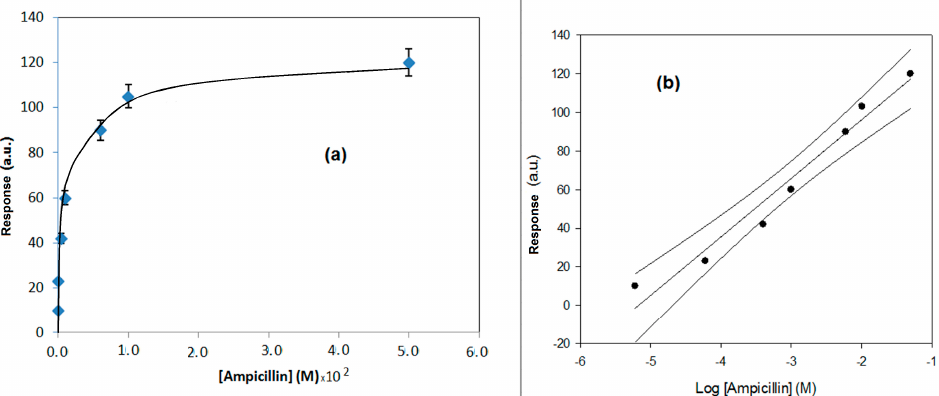
Figure 6. ( a ) Behavior of the response of the direct method based on flow SPR vs. concentration, for ampicillin determination. ( b ) Calibration curve using a semi-logarithmic scale and confidence interval, obtained by the direct method, based on flow SPR, for ampicillin determination. Sensors 2017 , 17 , 819